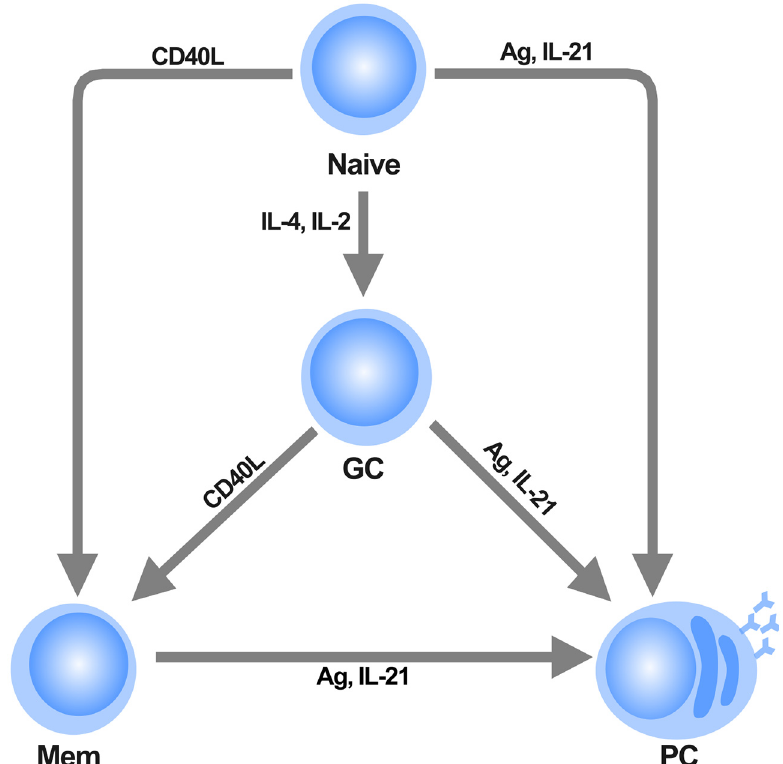
Fig 1. Terminal B cell differentiation. Precursor Naive B cells can differentiate into three possible cell types depending on proper molecular stimuli. Cytokines secreted by T-helper cells play a central role in the determination of B cell fate. IL-2 and IL-4 are required for the transition of Naive to GC cells. Direct contact of B cells with T cells by means of the CD40L receptor promote the differentiation of Naive or GC cells toward the Mem cell type. Antigen (Ag) activation drives terminal differentiation toward the PC cells, a process that is favored by the presence of IL-21.